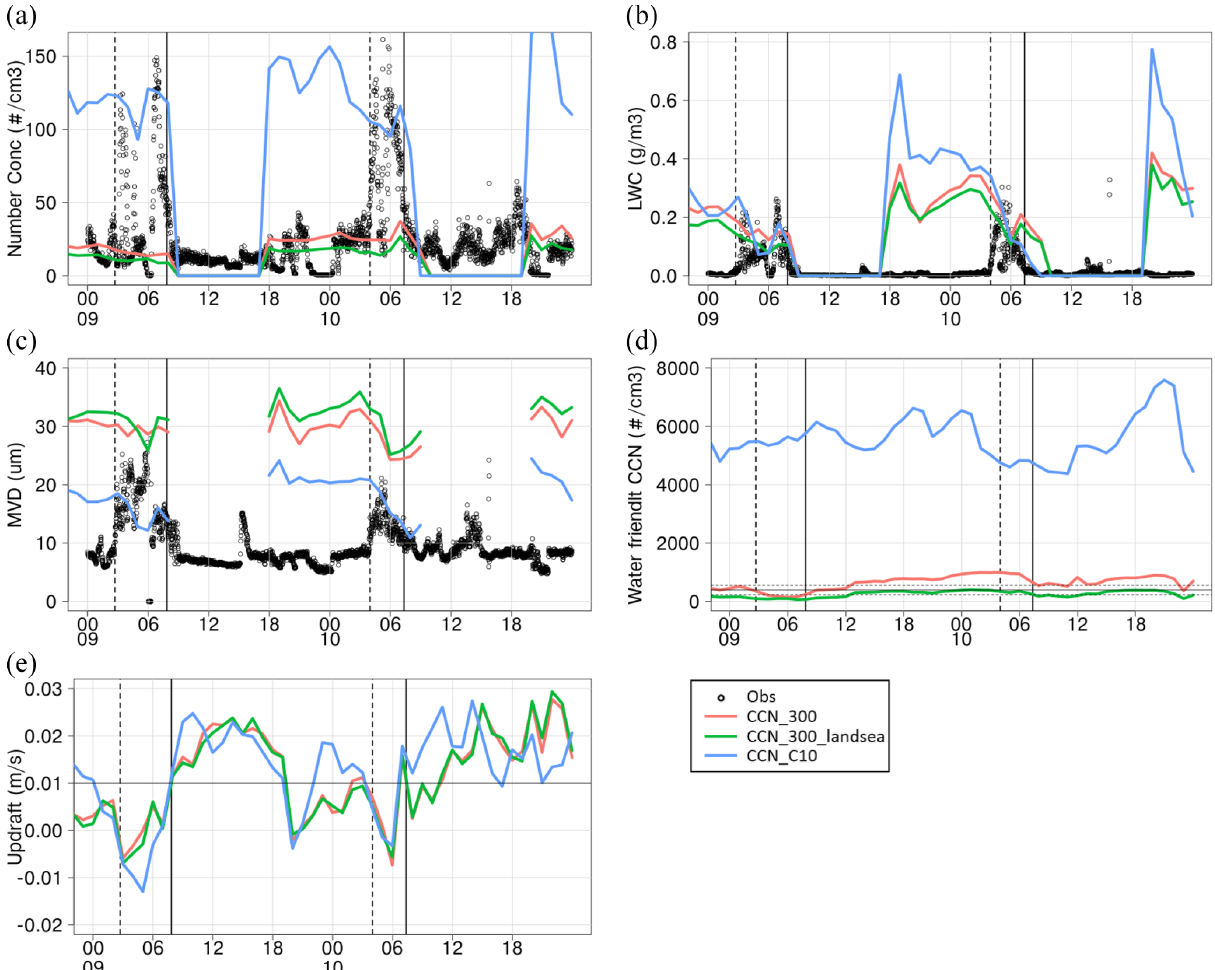
Figure 17. Observed and modelled (a) N t , (b) LWC, and (c) MVD at Henties Bay. The model is hourly, and black dots are 1min observations. (d) Modelled concentrations of water-friendly aerosols. (e) Modelled updraft speed in lowest model level with solid black line at minimum updraft in microphysics scheme. Time is in UTC (site is UTC + 2).